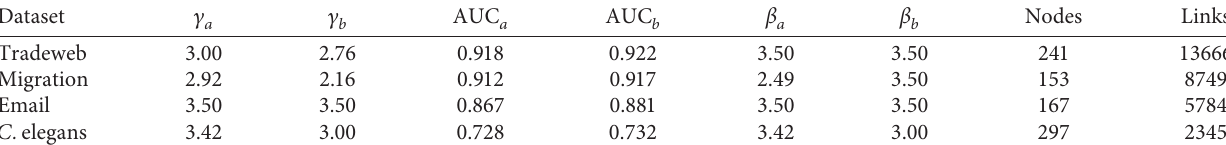
Table 1: The basic properties of empirical network data.